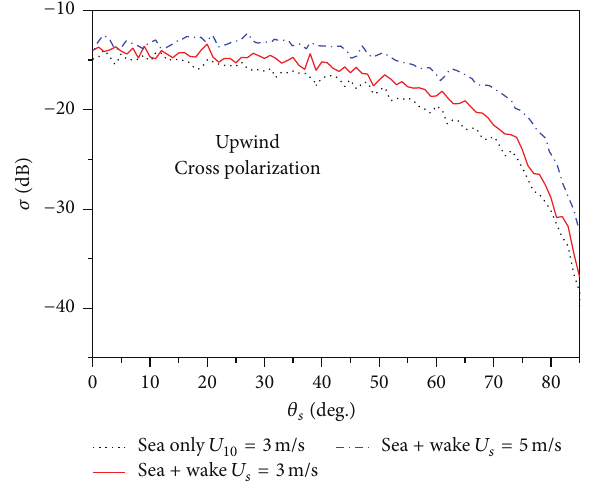
Figure 8: Cross-polarized backscattering coefficient from 2D rough sea surface with and without an embedded ship’s Kelvin wake with wind speed 𝑈 10 = 3